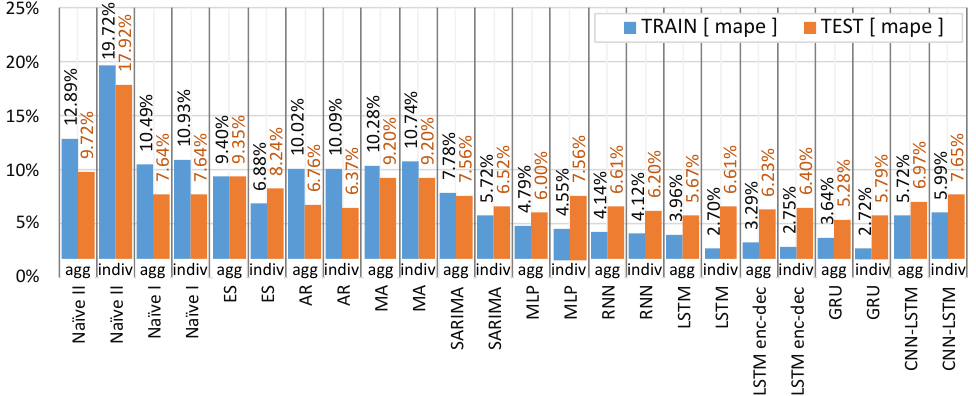
Figure 15. Aggregated forecast (agg) compared to the individual forecasts (indiv).